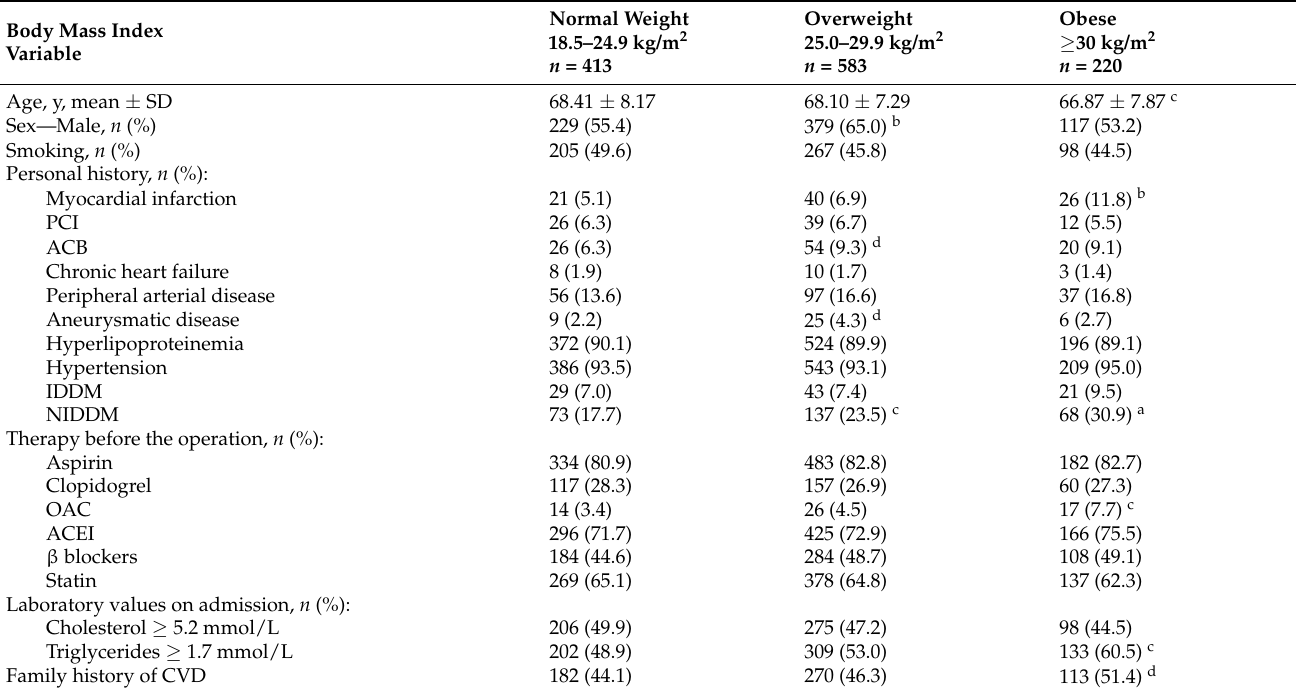
Table 1. Demographic characteristics, smoking, personal history, therapy, laboratory values on admission, and family history of cardiovascular diseases, by body mass index, according to the univariate logistic regression